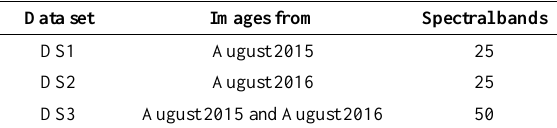
Figure 3. Radiometric reference targets for the empirical line